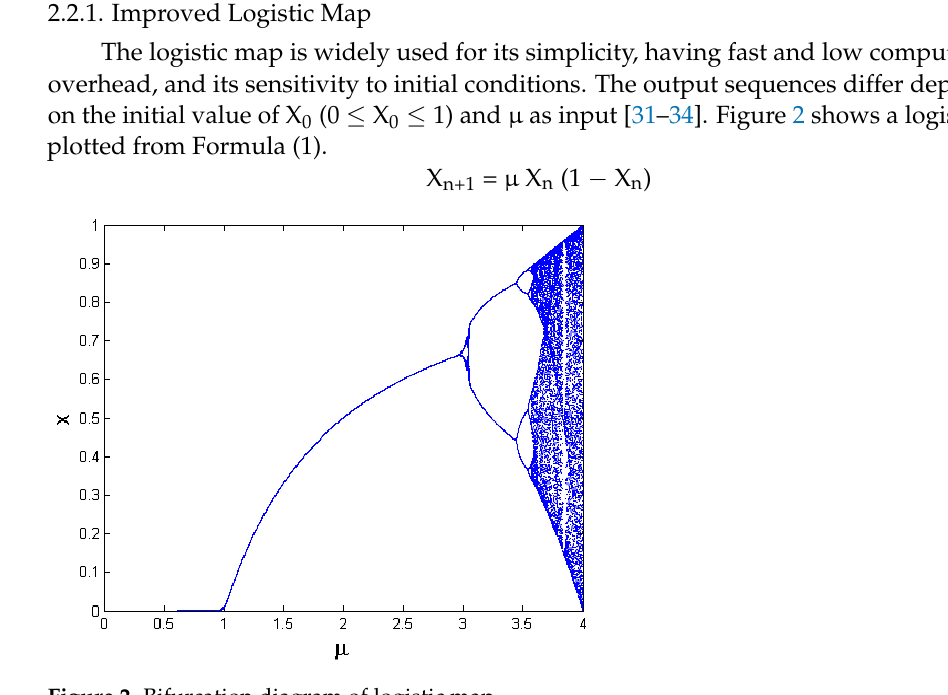
Figure 2. Bifurcation diagram of logistic map.